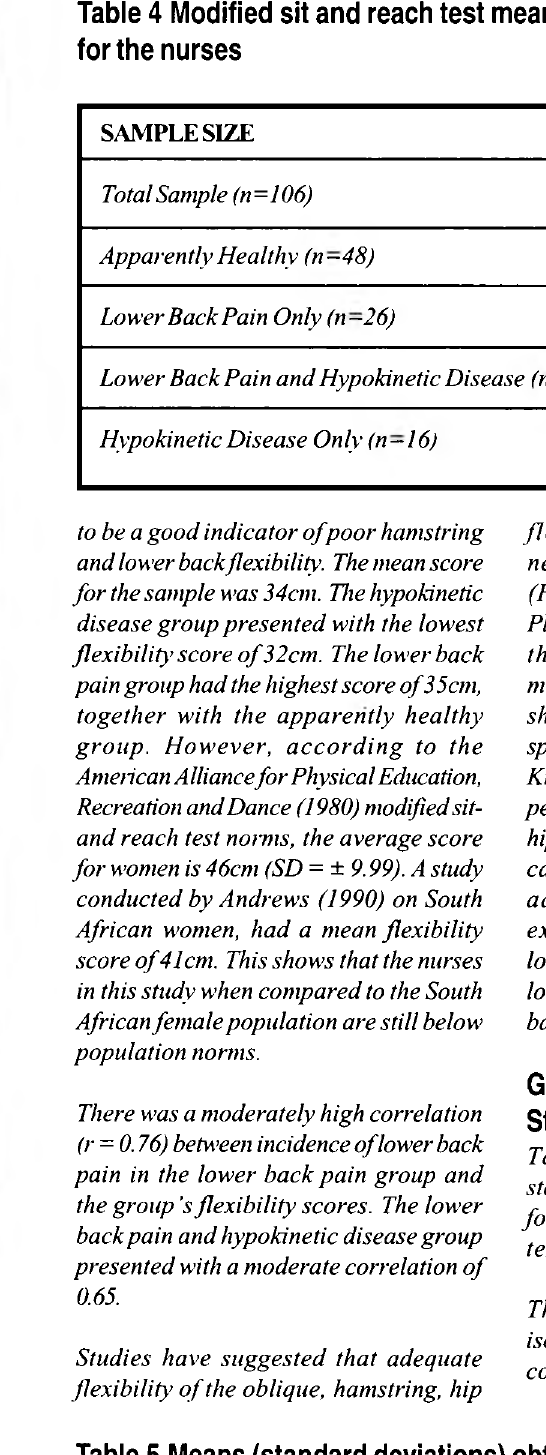
Table 5 Means (standard deviations) obtained from combined grip strength and back strength tests